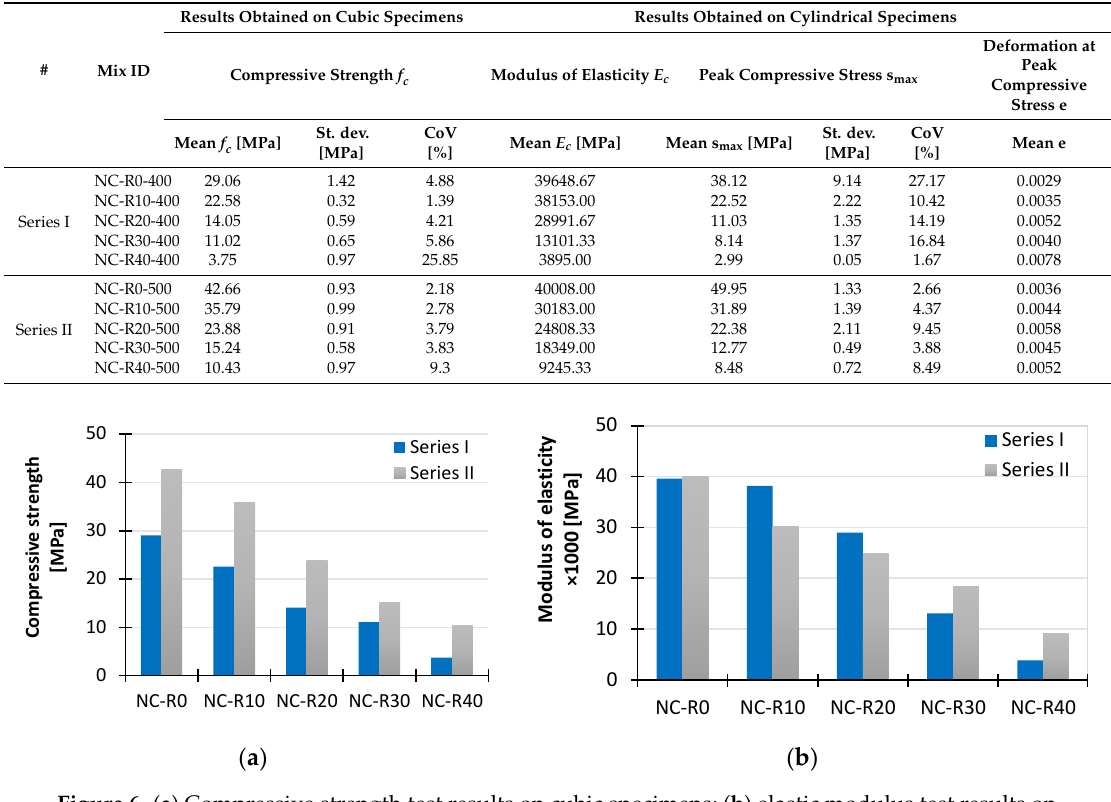
Table 5. Compressive strength, elastic modulus and stress-strain test results.